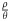
Estimated demographic history with selfing and seed banking.Demographic history estimated by eSMC for ten replicates using four simulated sequences of 10 Mb under a saw-tooth demographic scenario and four different combinations of germination (β) and self-fertilization (σ) rates but resulting in the same ρθ. Mutation and recombination rates are set to 2.5 × 10−8 per generation per bp, giving rμ=1. The four combinations are: a) σ = 0.4 and β = 0.25, b) σ = 0.75 and β = 0.6, c) σ = 0.85 and β = 1 and d) σ = 0 and β = 0.15. Hence, for each scenario ρθ=0.15 For each combination of β and σ, eSMC was launched with five different prior settings: ignoring seed-banks and self-fertilization (red), accounting for seed-banks and self-fertilization but without setting priors (blue), accounting for seed-banks and self-fertilization with a prior set only for the self-fertilization rate (green), only for the germination rate (orange) or for both (purple). σ* and β* respectively represent the estimated self-fertilization and germination rate.